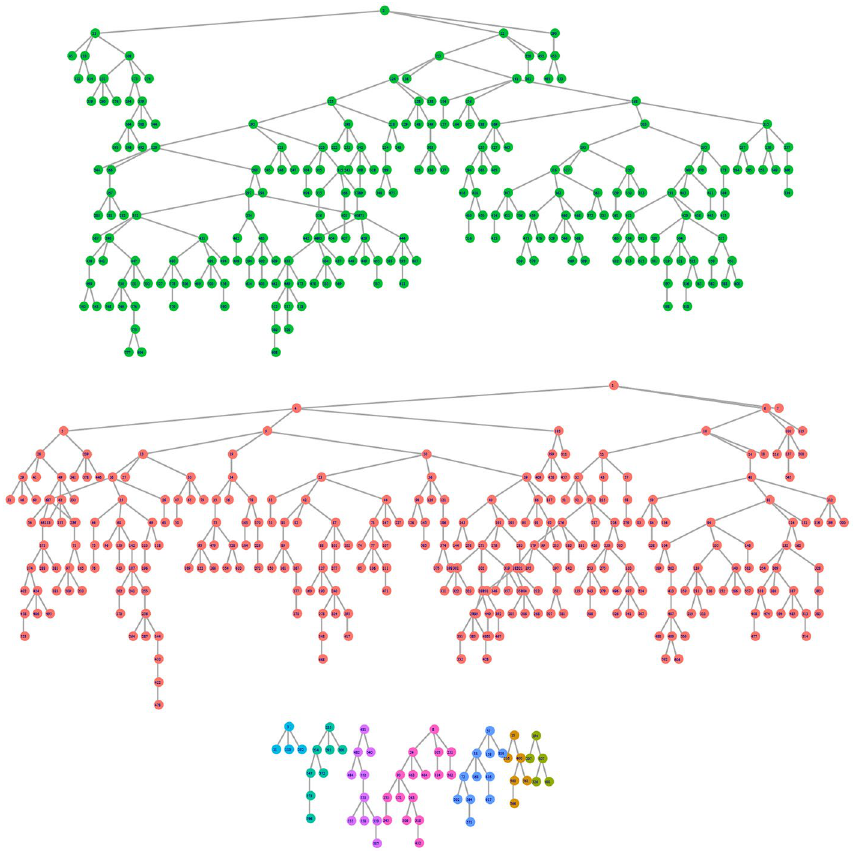
Figure 2. Recruitment trees of MSM in 2021. Each point represents a participant, the recruitment order is from top to bottom, and the short line represents the recruitment relationship. Dots of the same color indicate those recruited by the same seed.